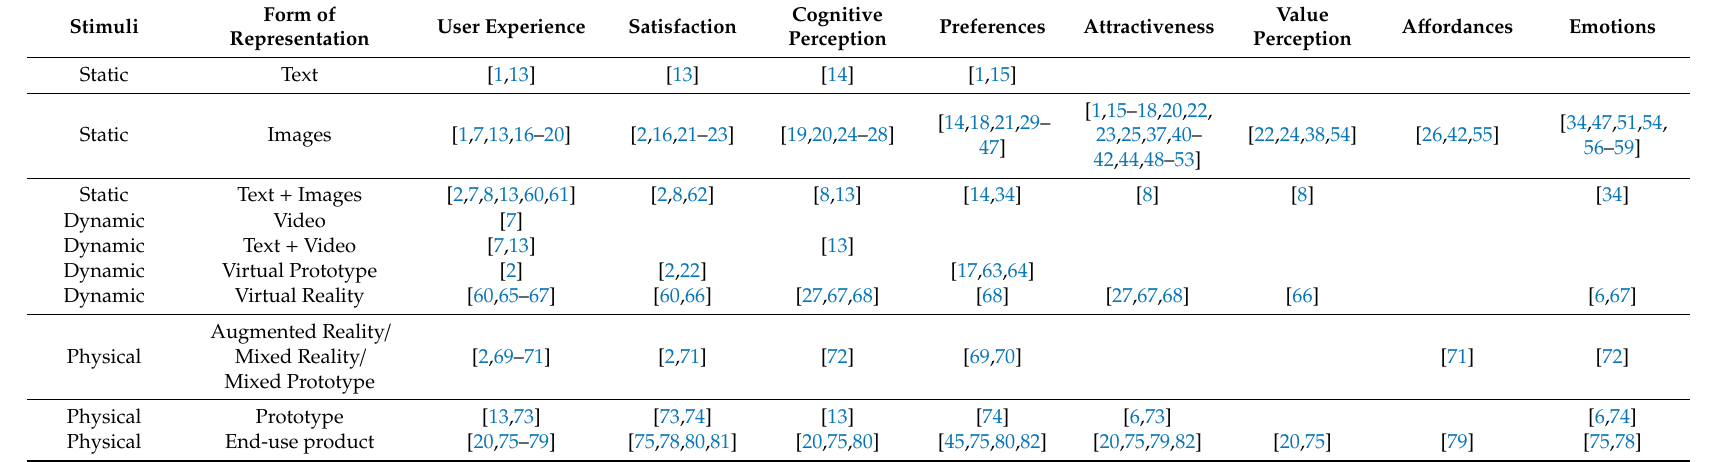
Table 1. Organization of literature contributions with respect to representation forms and